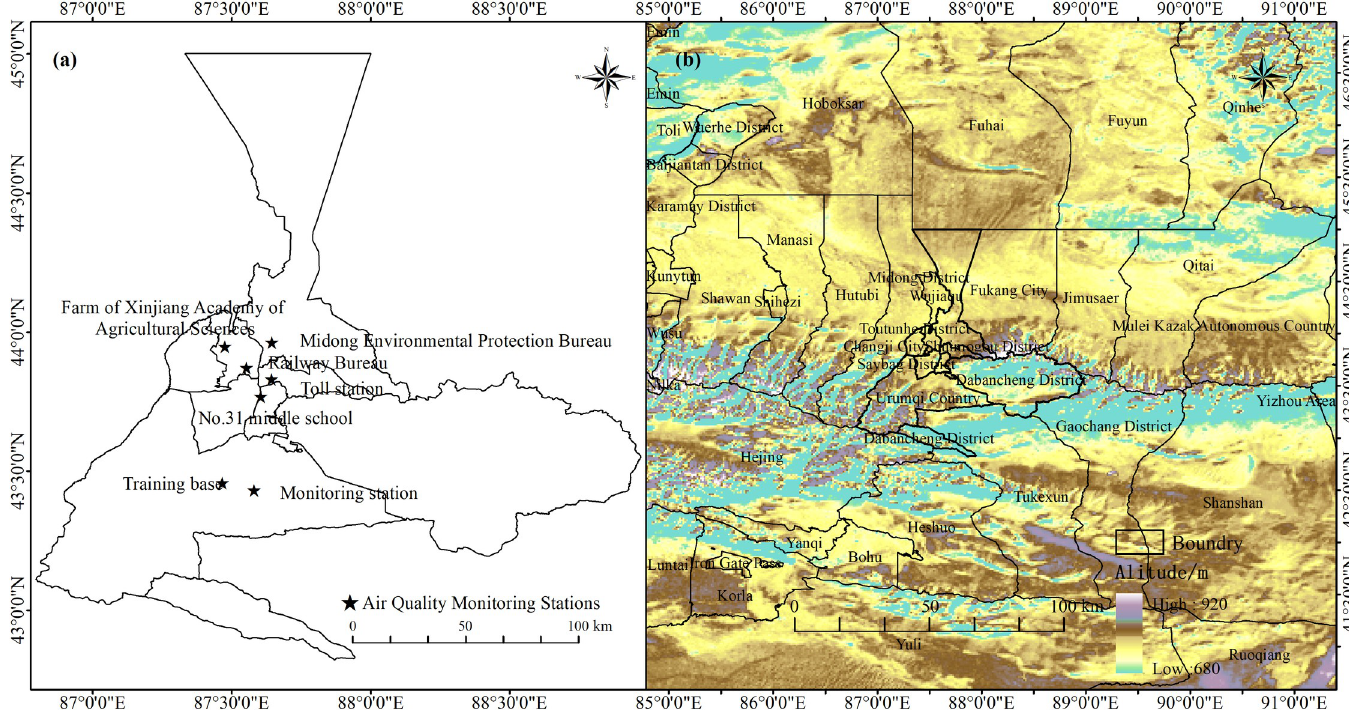
Fig 1. Map of study area ((a)Location and distribution of monitoring stations; (b)Orographic distribution in Urumqi and its surrounding areas).